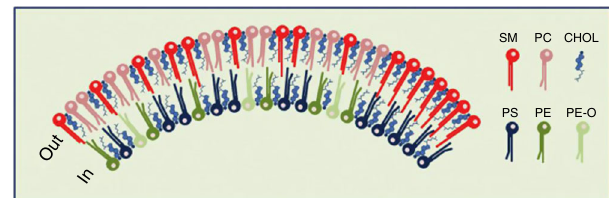
Fig. 3 Schematic model of the lipid bilayer of exosomes. The number of lipid molecules (excluding cholesterol) shown in the outer (29) and inner (21) lea fl et is close to the ratio for the outer and inner surface of exosomes with a diameter of 70 nm. The lipid composition of the membrane in this simpli fi ed illustration is based on the quantitative lipidomic data reported for 22 lipid classes of exosomes excreted from PC-3 cells 11 , i.e.,16 SM, 13 PC, 12 PS, 6 PE, 3 PE O (PE ethers) and 39 molecules of cholesterol (assuming a close to symmetric distribution of cholesterol between the two lea fl ets). In the right part of the membrane, a possible handshaking between the very-long-chain sphingolipids in the outer lea fl et and PS 18:0/ 18:1 in the inner lea fl et in the presence of cholesterol is illustrated. In the rest of the membrane, the lipids are distributed more or less evenly. Nine out of the 16 SM molecules shown contain a very-long-chain N-amidated fatty acyl group in accordance with the data published 11 . The fi gure is reproduced from ref.